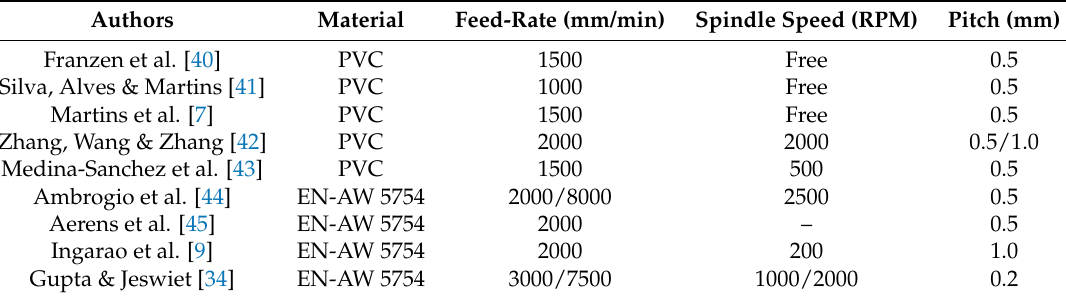
Table 2. Parameters used in literature for SPIF of PVC and EN-AW 5754.